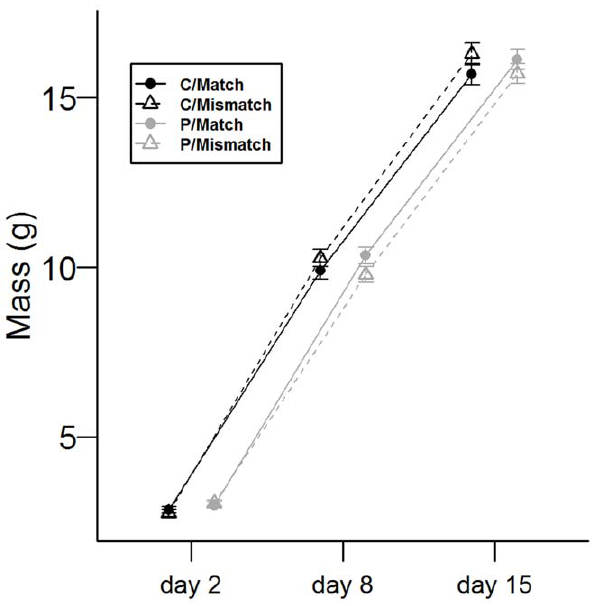
Figure 2. Mass growth curves. Nestling mass on three measurement days (Mixed Effects Model estimations of mean 6 SE). The shape of growth curves differed significantly according to the interaction between the treatments. When mothers were exposed to predation risk before or during ovulation, growth depended on offspring environment. When growing with predation risk, i.e. a matching environment, early growth rate increased (steeper slope between days 2–8) compared to mismatching conditions. Under mismatching conditions, the fast mass gain, as well as reaching asymptotic mass, was postponed. C=mothers exposed to control treatment; P=mothers exposed to predator treatment.